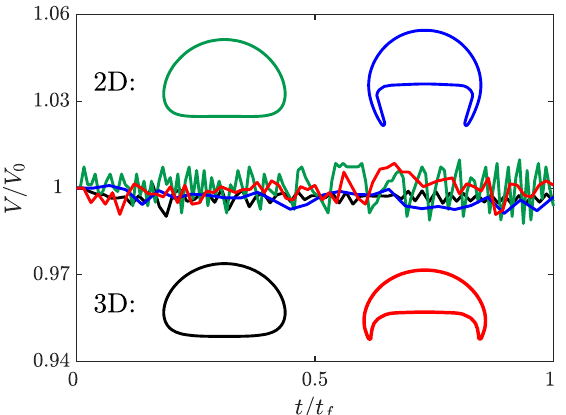
Figure 3. The bubble volume as a function of time normalized with respect to the final bubble volume. The normalized volume of the two (green) and three (black) dimensional spherical bubbles and the two (blue) and three (red) dimensional skirted bubbles are presented as a function of the normalized time. The shapes of the two (top) and three-dimensional (bottom) bubbles are presented as insets with the color of the interface corresponding to the normalized volume